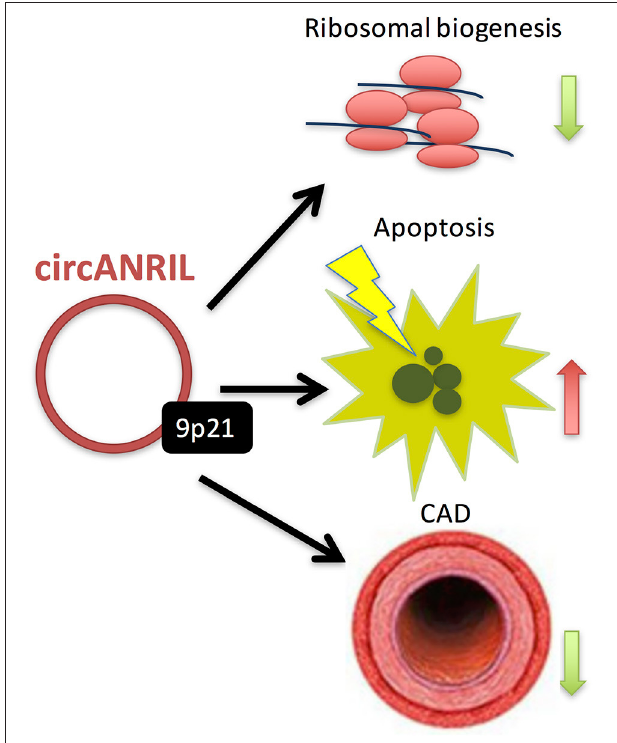
FIGURE 6 | Recently, Holdt et al. (69) demonstrated that circANRIL regulates the maturation of precursor ribosomal RNA (pre-rRNA), by this impairing ribosome biogenesis and inducing nucleolar stress and apoptosis in vascular smooth muscle cells and macrophages. Moreover, carriers of the CAD-protective haplotype at 9p21 showed significantly increased expression of